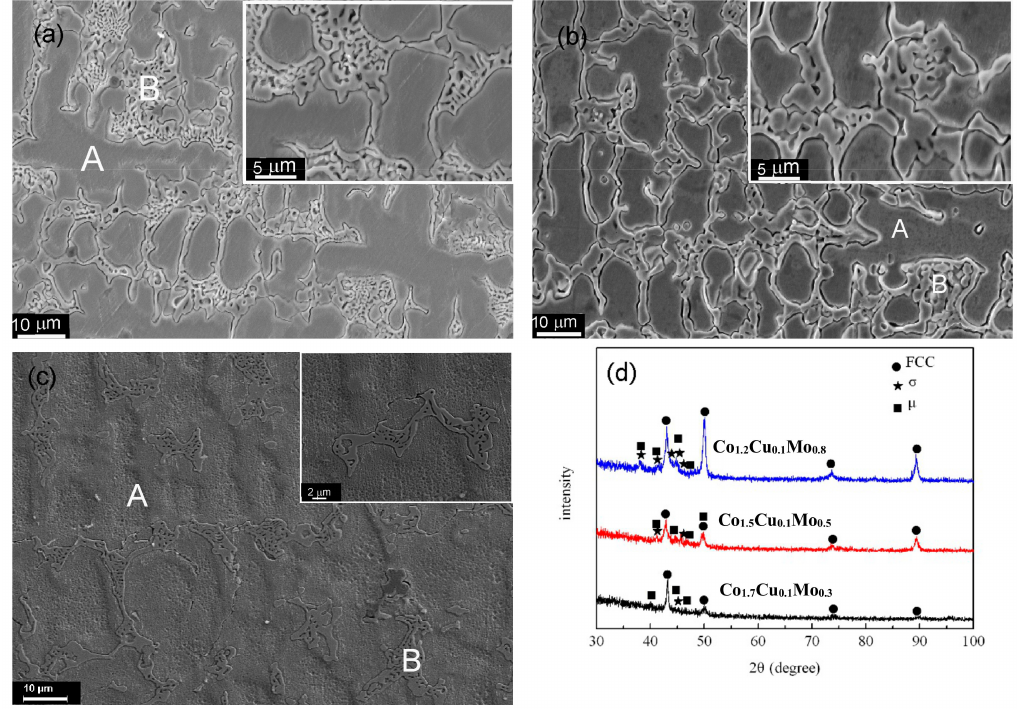
Figure 1. The microstructures and phases of Co a CrCu 0.1 FeMo 2 − a Ni HEAs. ( a ) Co 1.2 CrCu 0.1 FeMo 0.8 Ni; ( b ) Co 1.5 CrCu 0.1 FeMo 0.5 Ni; ( c ) Co 1.7 CrCu 0.1 FeMo 0.3 Ni; ( d ) X-ray diffractometer (XRD)